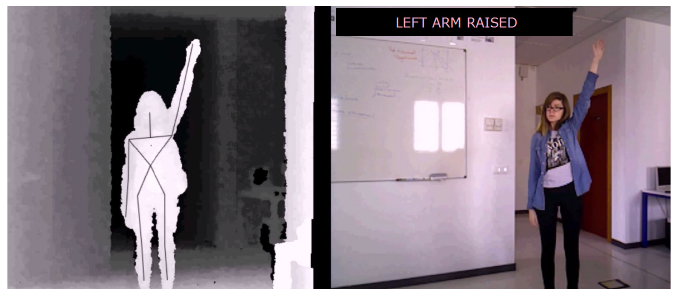
Figure A4. Left arm raised detection.